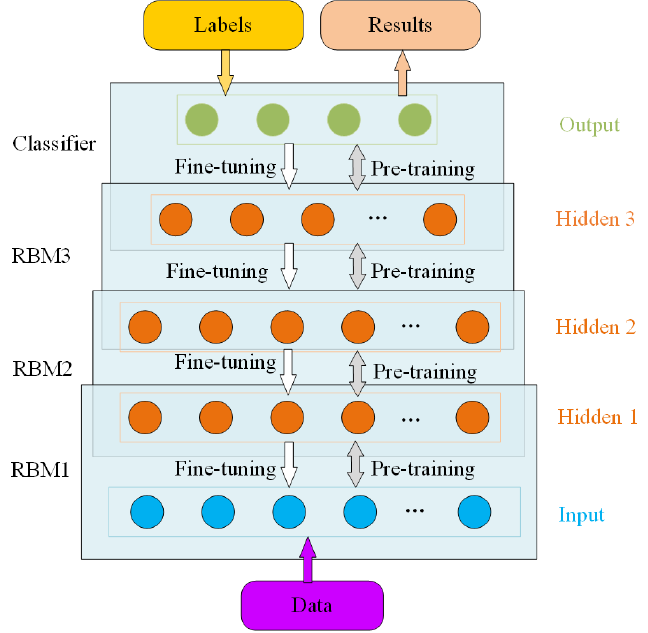
Figure 2. Structure and training process of DBN.